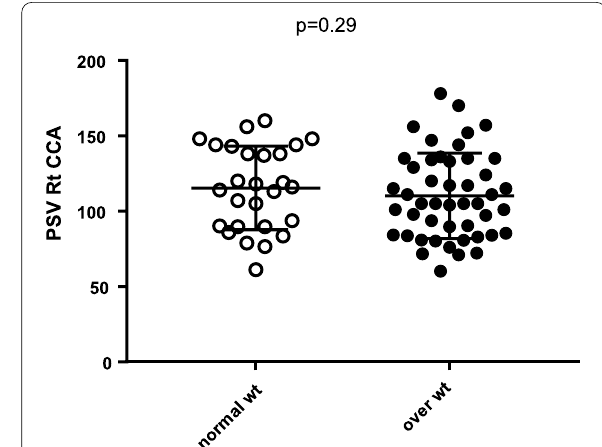
Fig. 3 Student’s T -test comparing the peak systolic velocity in the right common carotid with different groups of body mass index, mean flow velocity in normal wt group flow velocity in over wt group